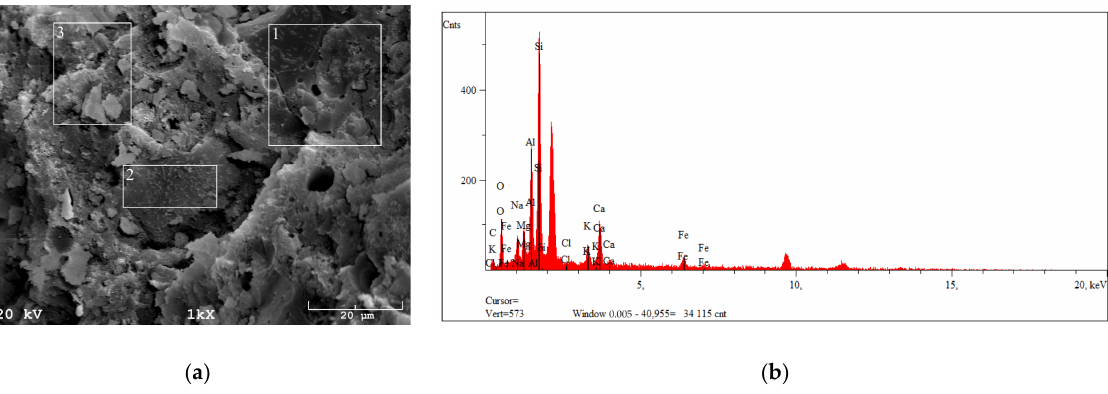
Figure 5. Sample G 200–900 ( a ) with marked areas of measurements, ( b ) results of the EDS analy-